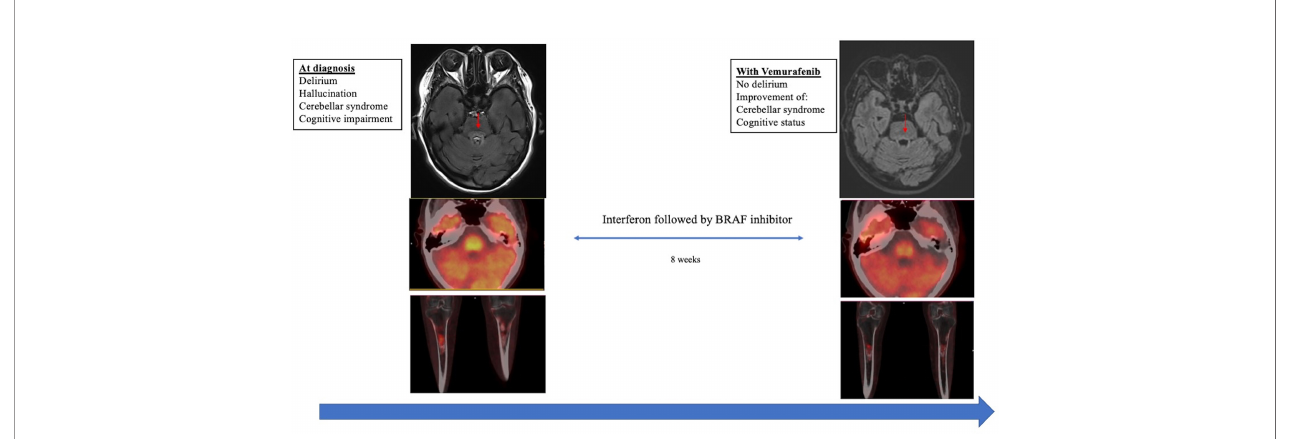
FIGURE 3 | Radiological and metabolic evolution of the ECD patient before and after vemurafenib. On the left side of the fi gure: imaging at ECD diagnosis before speci fi c treatment. From top to bottom: axial brain MRI showing FLAIR change lesions in the pons at ECD diagnosis (upper image). Axial 18 F fl uorodeoxyglucose positron emission tomography at diagnosis showing radiotracers in the pons (middle image) and in long bones at ECD diagnosis (bottom image). On the right side of the fi gure: imaging after 8 weeks treatment with vemurafenib. From top to bottom: axial brain MRI showing a decrease in the intensity of the FLAIR signal in the pons after vemurafenib (upper image). Axial 18 F fl uorodeoxyglucose positron emission tomography after vemurafenib showing a slight decrease of radiotracer uptake in the pons (middle image) and in long bones (bottom image) consistent with partial metabolic response using PERCIST criteria.